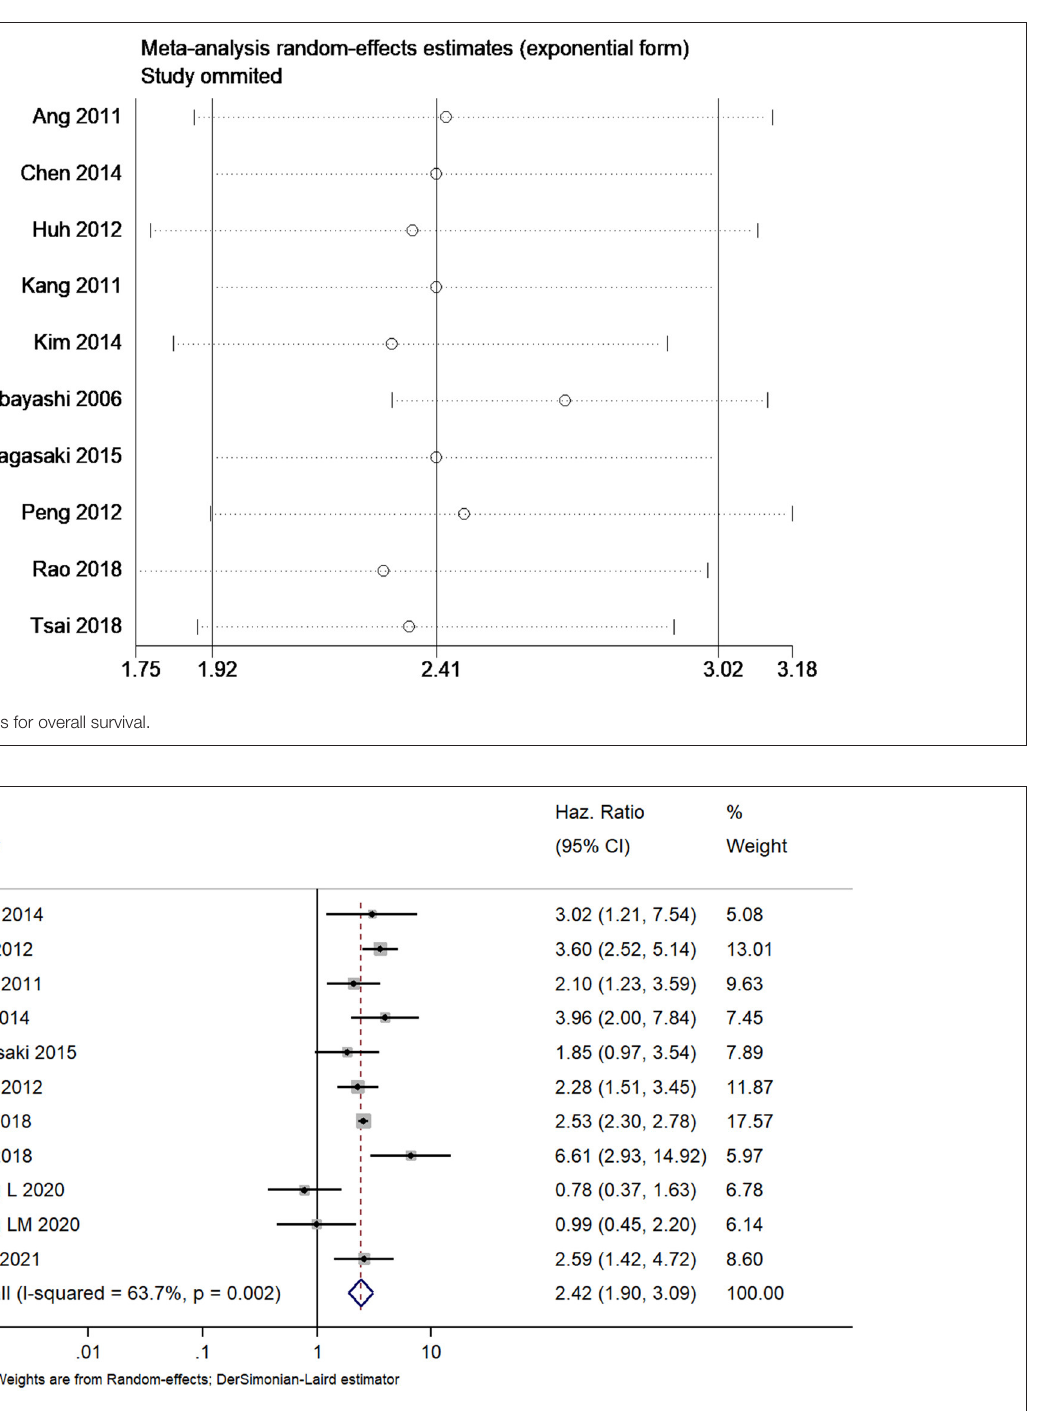
down regulated in the patients with colorectal cancer